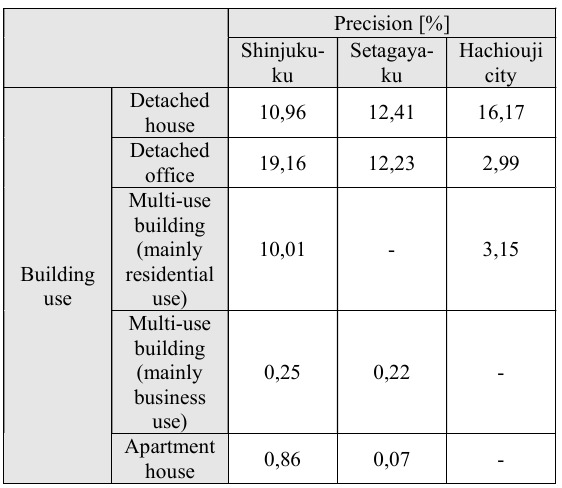
Table 2 . Accuracy for each municipality